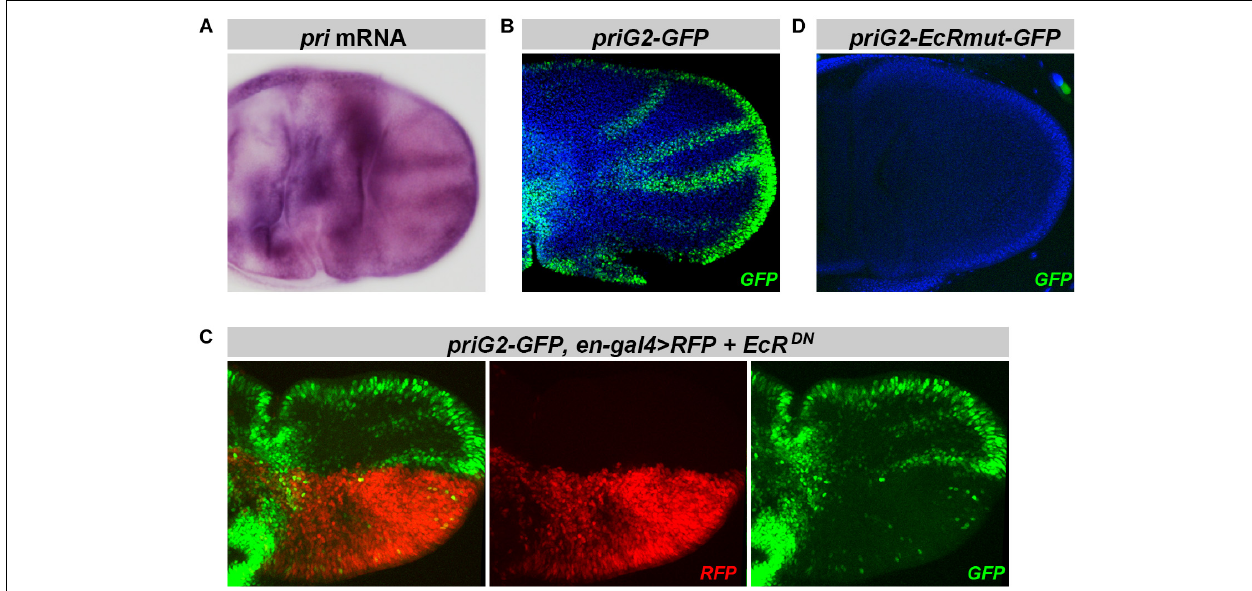
FIGURE 7 | Expression of priG2 in the pupal wing primordia is controlled by EcR. (A) Picture of in situ hybridization showing that pri is expressed in the pupal wing primordia (3–5 h APF), with a stronger signal in the presumptive regions of adult veins [see also Pi et al. (2011)]. (B) pri-G2 displays a pattern reproducing pri mRNA distribution in the wing disk. (C) Expression of EcR DN under the control of en-gal4 (monitored by the expression of RFP, in red) decreases priG2 activity in corresponding posterior cells. (D) Point mutations that inactivate both putative EcR binding sites within the priG2 sequence abrogate priG2 activity in pupal wing disks. GFP is shown in green, RFP in red, and DAPI is in